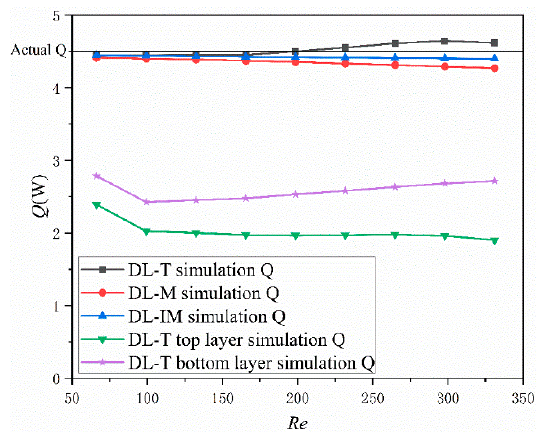
Figure 5. Comparison of heat input in different microchannels.